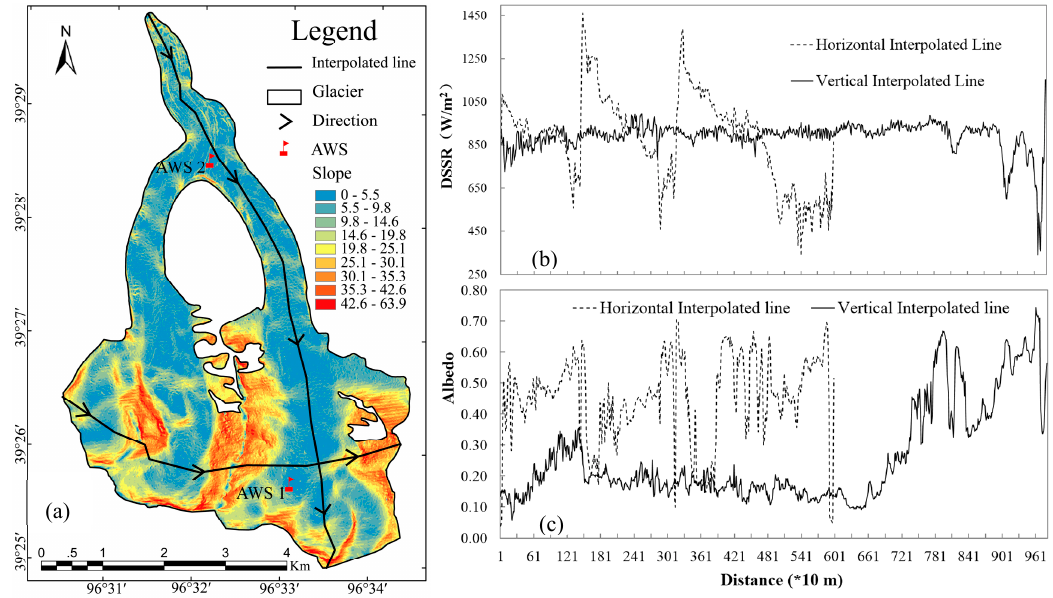
Figure 6. Spatial profile characteristics of the instantaneous DSSR and albedo at the S2A/B overpass time on 17 August 2018: ( a ) locations of the two interpolated lines; ( b ) DSSR profile analysis; and ( c ) albedo profile analysis.